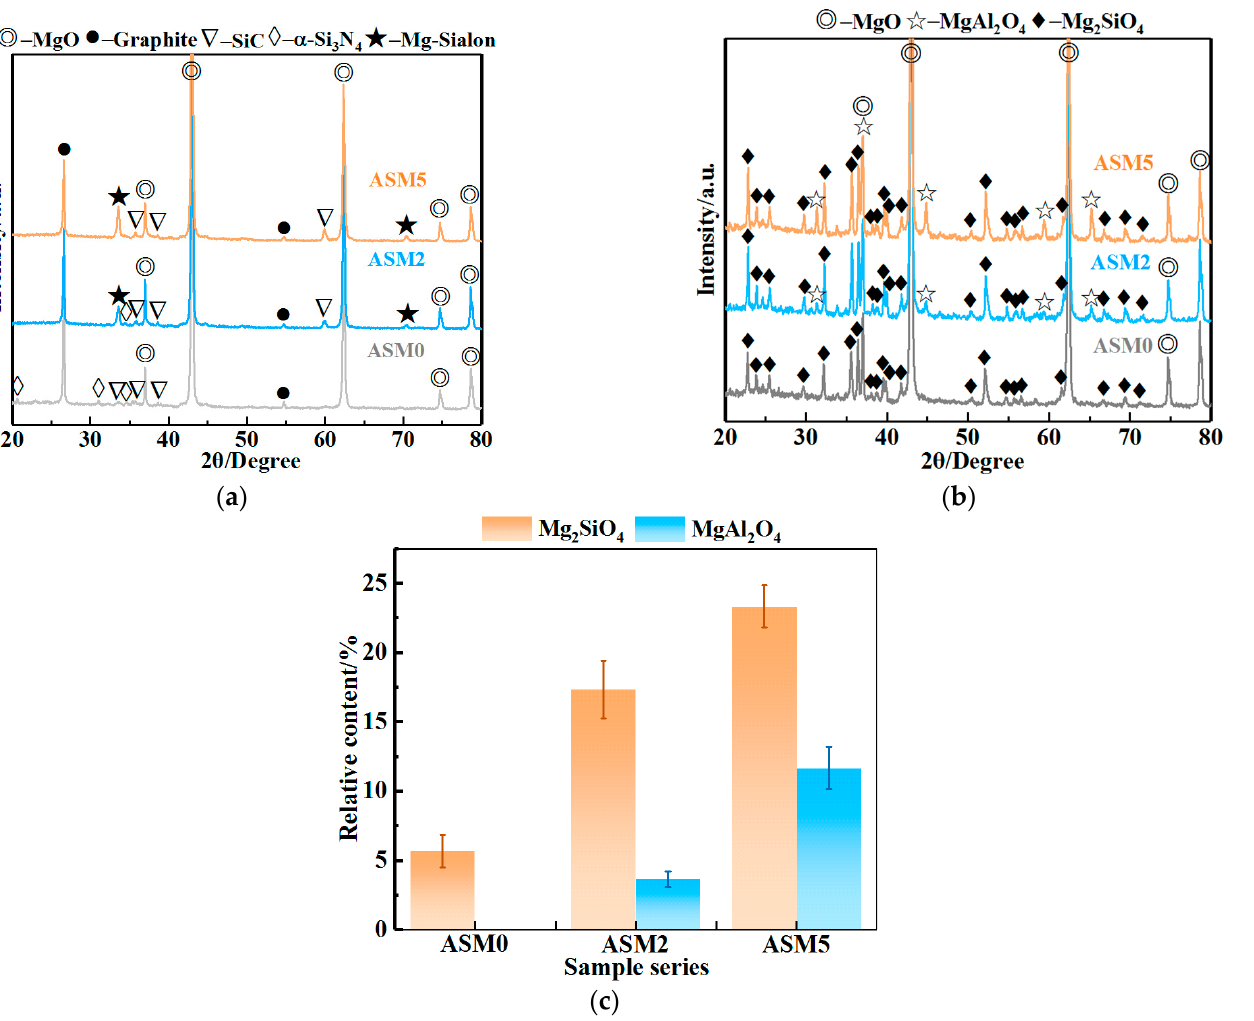
Figure 3. XRD patterns of MgO-C samples before ( a ) and after ( b ) the high-temperature oxidation test and the relative content of Mg 2 SiO 4 and MgAl 2 O 4 ( c ) in the oxidation samples. The ∆ r G θ for Equations (5) and (6) could not be calculated due to a lack of thermody- namic data from the Mg-sialon phase (Mg 3.29 Si 1.89 Al 2.82 O 4.41 N 4.59 ), and this reaction was given based on the relevant references and the present experimental results [26]. Mean- while, the thermodynamic calculations for Equations (4) and (7) are shown in Figure 4. The ∆ θ for these equations was negative at 1000~1500 ◦ C, illustrating that these reactions r G could proceed toward the right. Based on Equations (5) and (6), Al 2 O 3 and SiO 2 would form through the oxidation of Mg-sialon, which favored the occurrence of Equations (4) and